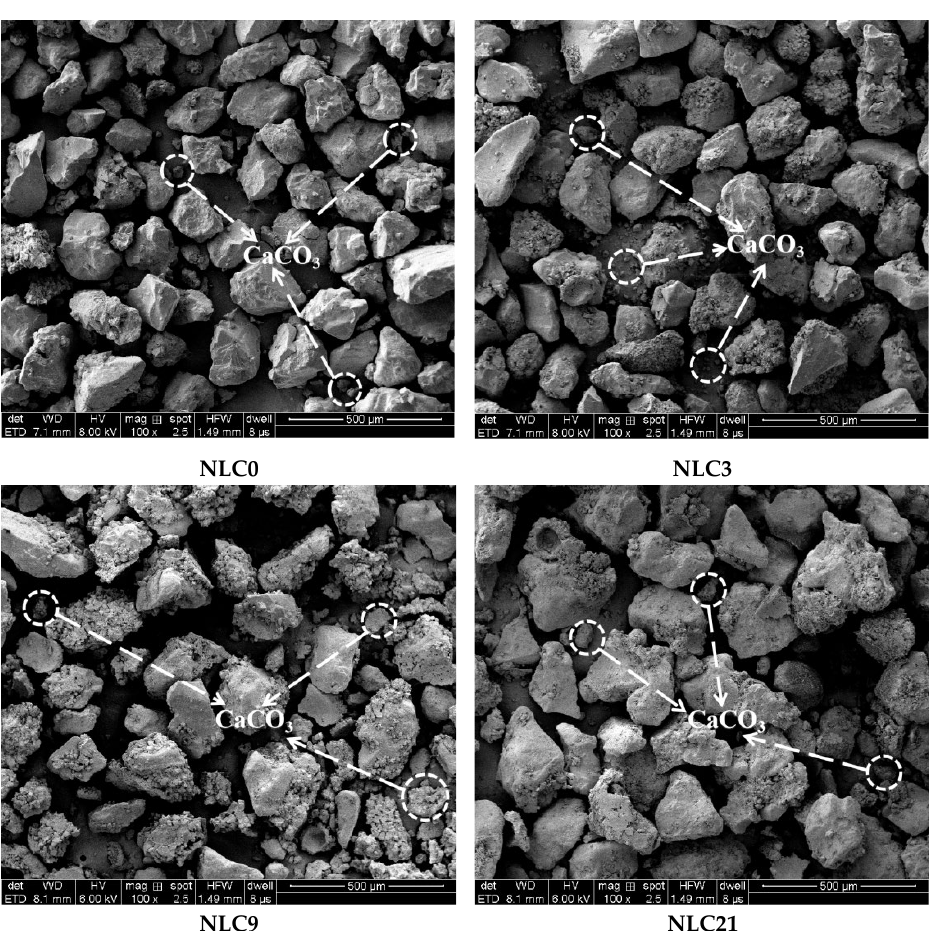
Figure 14. SEM image with different clay contents (100×).